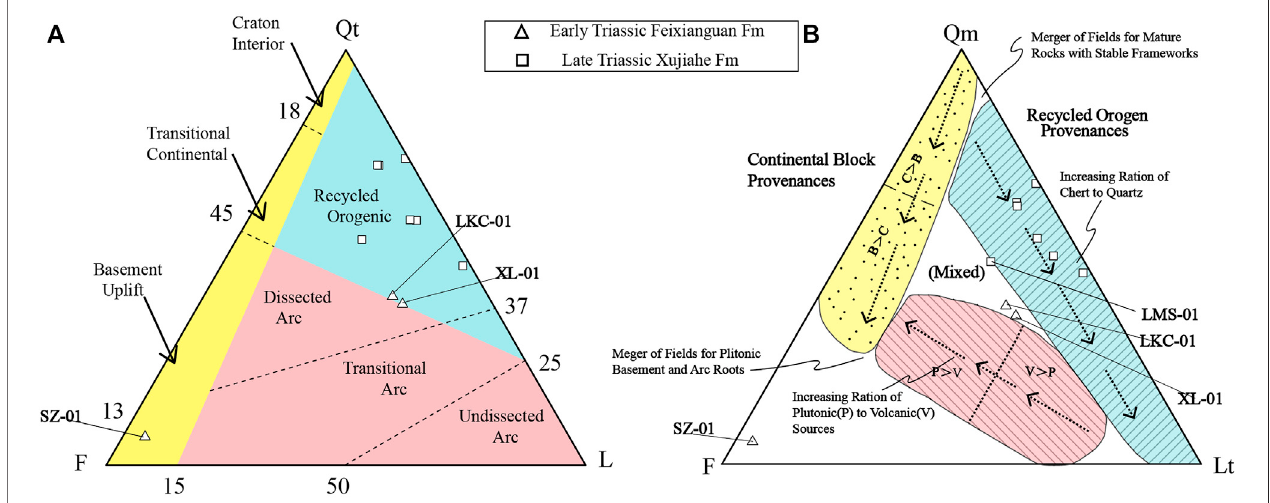
FIGURE 8 | Modal triangle diagrams of detrital composition in sandstones: Qt-F-L (A) and Qm-F-Lt (B) (Dickinson et al., 1982; Dickinson et al., 1983; Dickinson et al., 1985). Abbreviations: Qt, total quartz (Qm + Qp); F, total feldspar; L, lithic fragment; Qm, monocrystalline quartz; Qp, polycrystalline quartz; Lt, L + Qp.